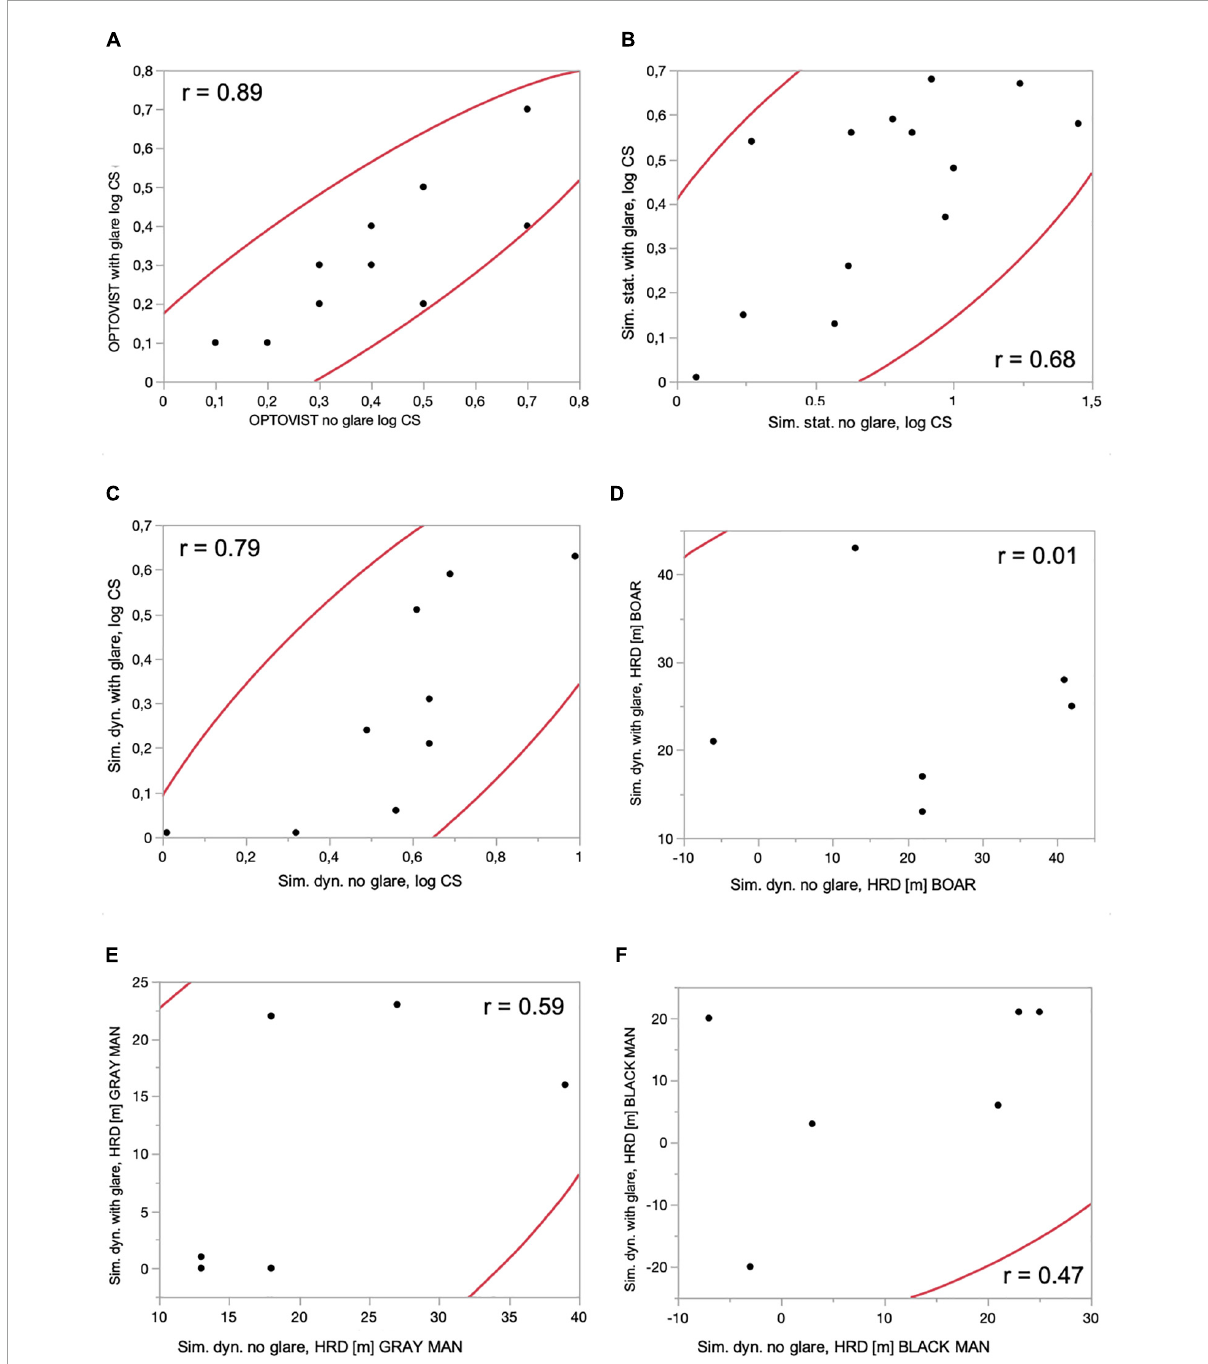
FIGURE4 Correlations between log CS and hazard detection distances – when comparing the with and without glare conditions, under clinical (Optovist I) or driving simulator conditions, with associated 95% confidence ellipses and correlation coefficients. (A) Clinical tests : contrast sensitivity (log CS): Optovist I without glare and with glare. (B) Driving simulator : contrast sensitivity (log CS): static conditions, ADAPTIVE thresholding algorithm (BestPEST), without and with glare exposition. (C) Driving simulator : contrast sensitivity (log CS): dynamic conditions, ADAPTIVE thresholding algorithm (BestPEST), without and with glare exposition. (D) Driving simulator : dynamic conditions, hazard recognition distance (m) BOAR (Weber contrast 87%), without and with glare exposition. (E) Driving simulator : dynamic conditions, hazard recognition distance (m) GRAY MAN (Weber contrast 81%), without and with glare exposition. (F) Driving simulator : dynamic conditions, hazard recognition distance (m) BLACK MAN (Weber contrast 29%), without and with glare